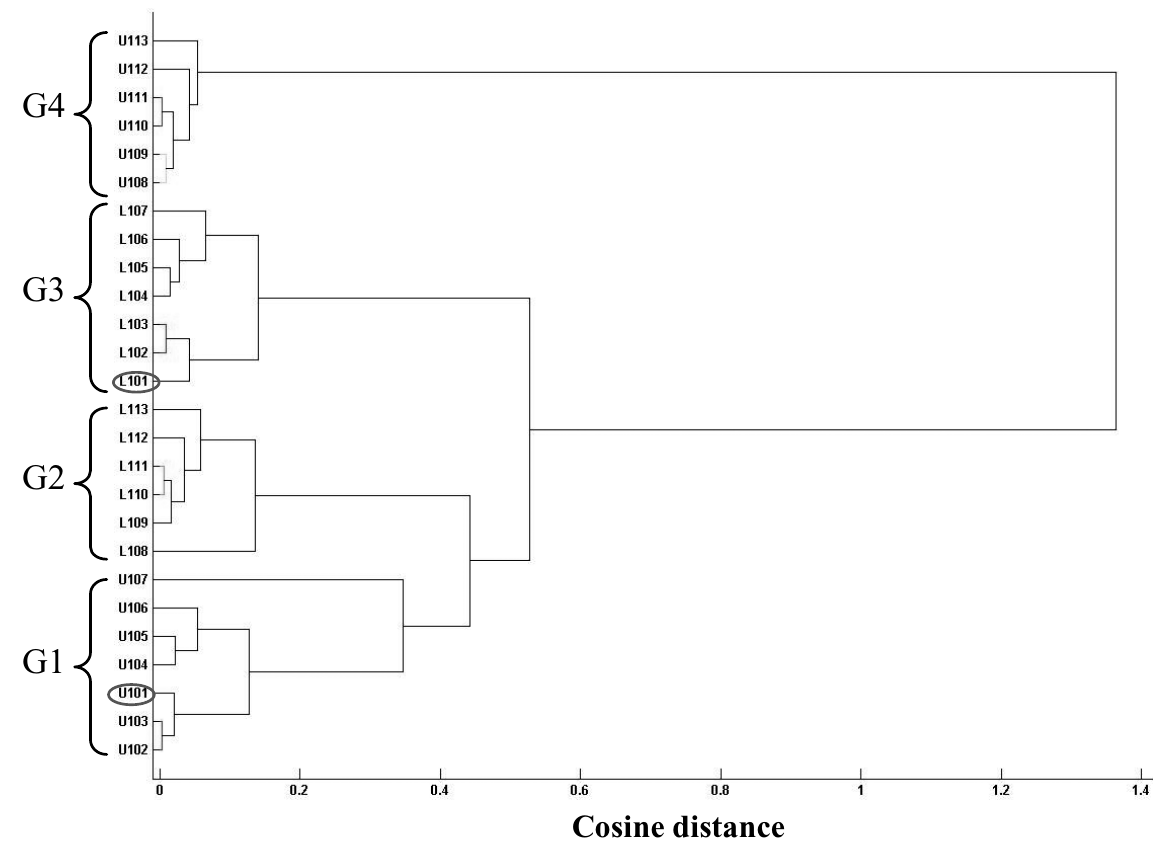
Fig. 4. Hierarchical clustering (UPGMA) of the 26 columns of sensitivity results of the tail sections (upper and lower